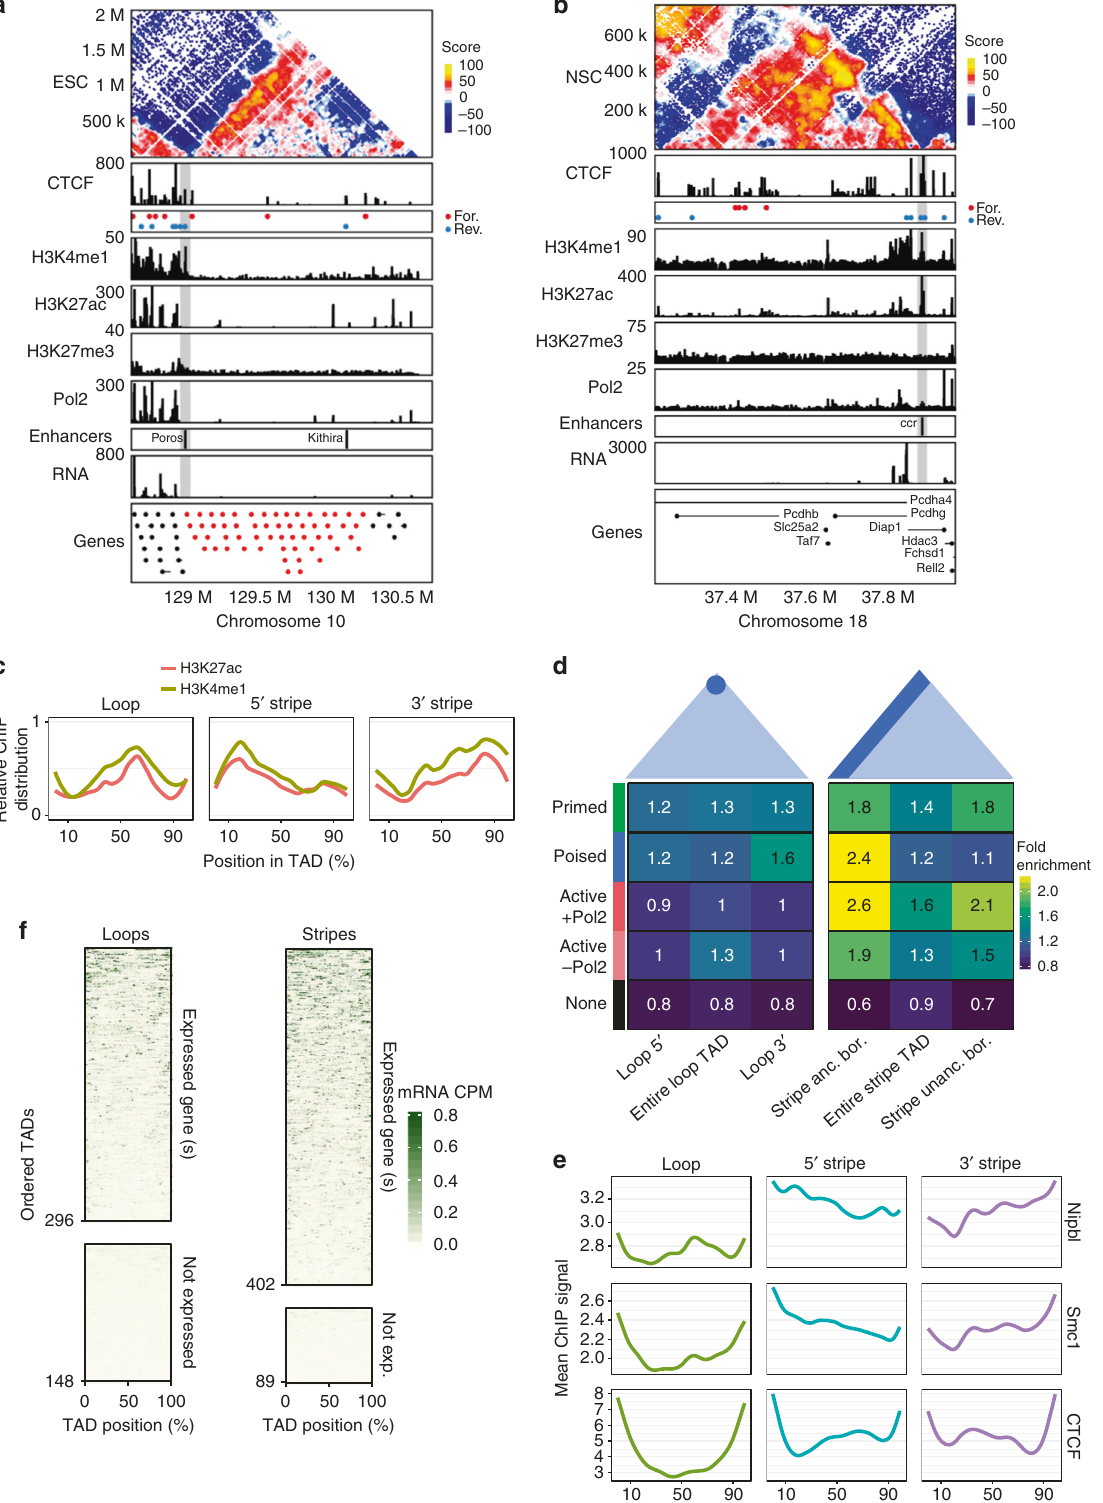
the distribution of enhancer marks and pluripotency TFs (Fig. 3c), the distributions of NIPBL, CTCF, and cohesin across TADs were distinct between TAD classes (Fig. 3e). In active compartment loop domains, there was an overall lower level of NIPBL signal compared to stripe domains and NIPBL was less